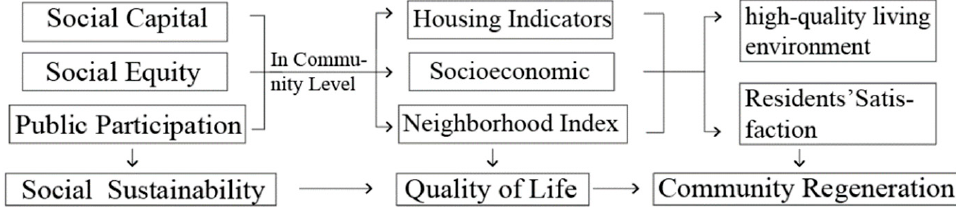
Figure 1. QoL as the mediating link for social sustainability and old community regeneration.